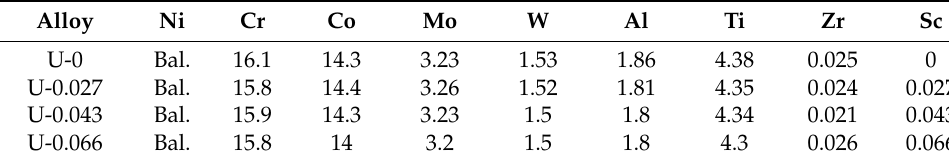
Table 1. Chemical composition of Sc-doped U720Li powder in wt.%. Alloy